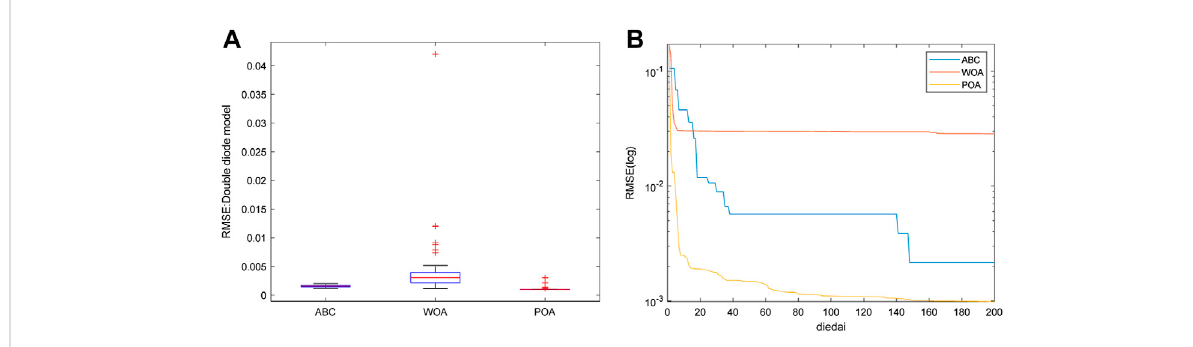
FIGURE 6 Boxplot graph and convergence curve obtained by POA for DDM: (A) boxplot graph and (B) convergence curve.